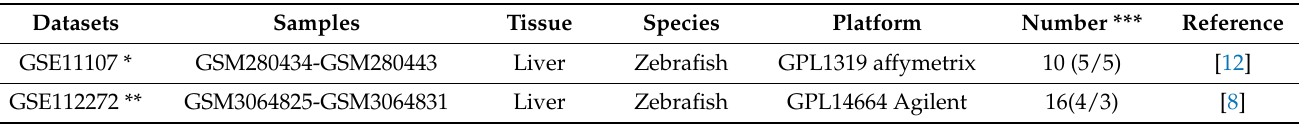
Table 2. Details for datasets used for